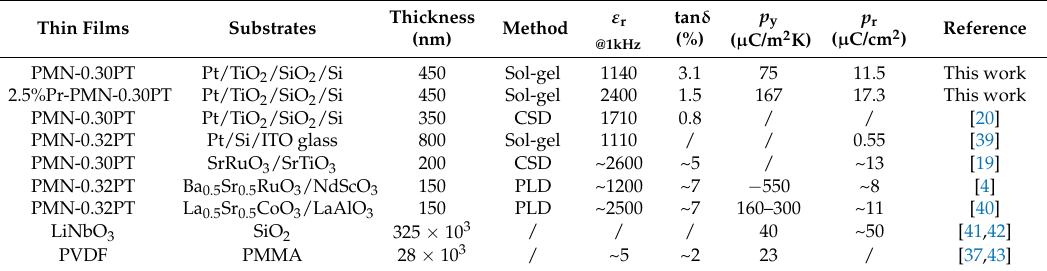
Figure 2. ( a ) FE-SEM images of surface morphologies for 2.5% Pr-PMN-PT thin films annealed at 650 ◦ C for 2 min, ( b ) FE-SEM images of cross-section of 2.5% Pr-PMN-PT thin films, ( c ) grain size distributions of 2.5% Pr-PMN-PT thin films, ( d ) 2D piezoresponse force microscope (PFM) images of surface morphologies for 2.5% Pr-PMN-PT thin films, ( e ) 3D atomic force microscope (AFM) images of surface morphologies for 2.5% Pr-PMN-PT thin films, and ( f ) a schematic illustration of the device for electric properties measurement. Table 1. Dielectric, pyroelectric, and ferroelectric properties in (001)-oriented PMN-PT based ferroelectric thin films at room temperature.